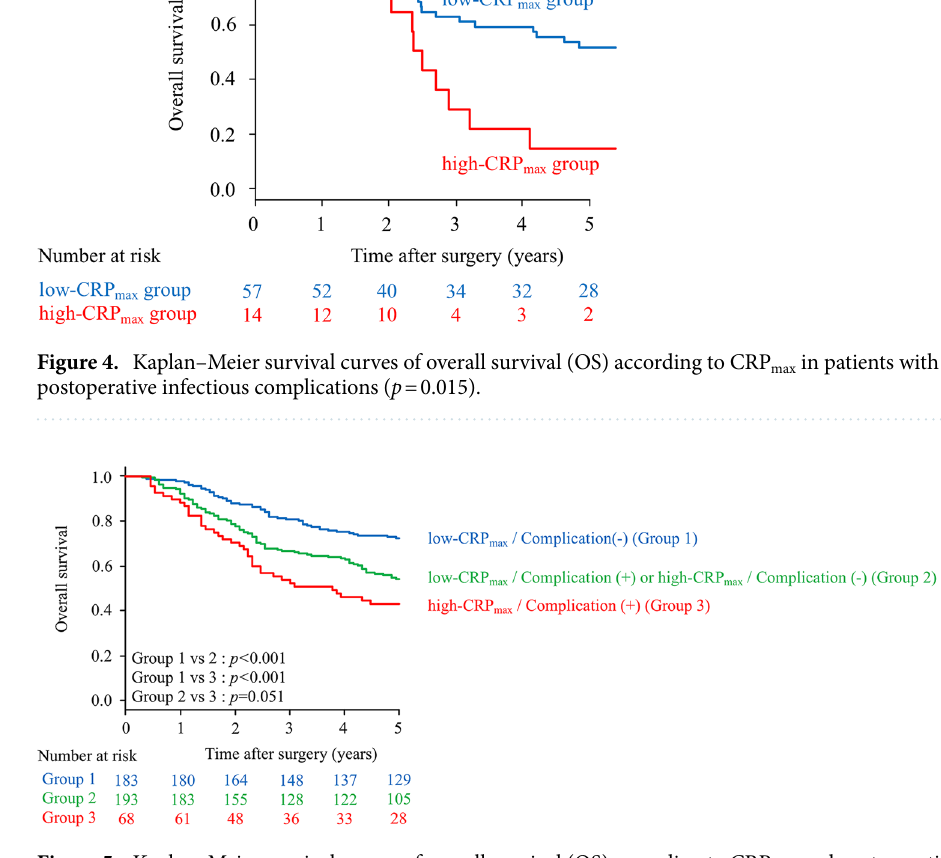
Figure 5. Kaplan–Meier survival curves of overall survival (OS) according to CRP max and postoperative infectious complication status (Group 1, high-CRP max with postoperative infectious complications; Group 2, either high-CRP max or the presence of postoperative infectious complications; Group 3, low-CRP max without postoperative infectious complications). The five-year OS rates in Groups 1, 2 and 3 were 73.5%, 56.5% and 43.1%, respectively (Group 1 vs Group 2: p < 0.001, Group 1 vs Group 3: p < 0.001, Group 2 vs Group 3: p = 0.051).